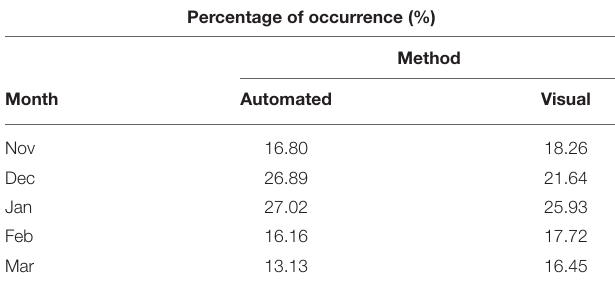
TABLE 2 | Monthly frequency of occurrence of active SACZ